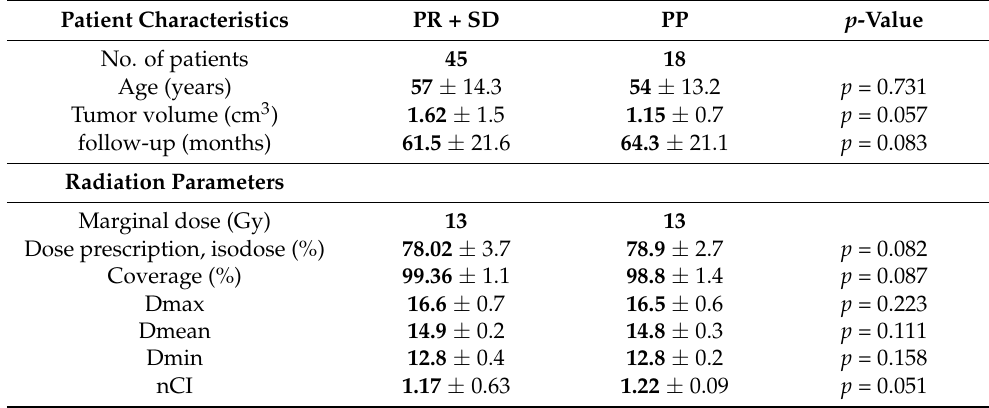
Figure 4. Illustrative case of a 56-year-old woman with a vestibular schwannoma that showed an increase in volume and was classified as late pseudoprogression. At the baseline, Cyberknife ® SRS with a radiation dose of 13 Gy was applied. During follow-up, a continuous volume increase could be observed with a maximum of % ∆ V = 225 after 48 months. Afterwards, until 72 months, the tumor volume regressed almost completely to baseline. Table 3. The comparison of pseudoprogression (PP) and partial response/stable disease (PR+SD) of the observed cohort after Cyberknife®SRS showed no significant difference (I > 0.05) with regard to patient and treatment